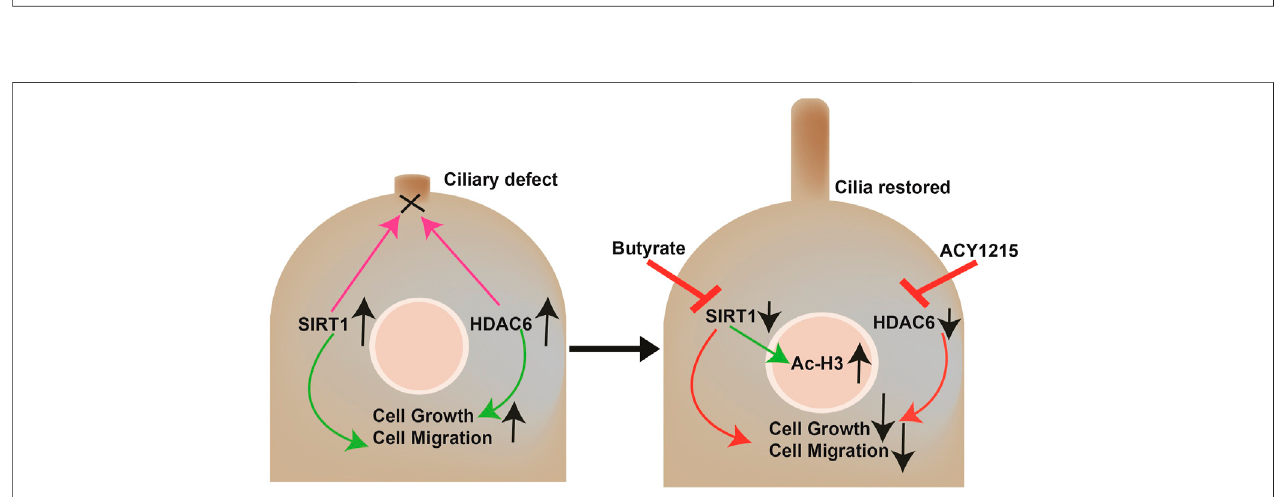
FIGURE 3 | assay was done in HuCCT1 cells in the presence of ACY1215 (0.5 and 1 μ M) and butyrate (0.5 and 1 mM). (G, H) Scratch assay was analyzed using IncuCyte; HuCCT1 cells were treated with ACY1215 (0.2 – 1 μ M) and butyrate (0.2 and 1 mM) for 48 h post-wound, and the remaining wound area was calculated. (I) Western blotting in HuCCT1 cells in the presence of ACY1215 (0.5 and 1 μ M) and butyrate (0.5 and 1 mM) was done for SIRT1, HDAC6, CD44, Cyclin D1, N-Cadherin, PCNA, Vimentin, and Zeb1. β -actin was used as loading control.